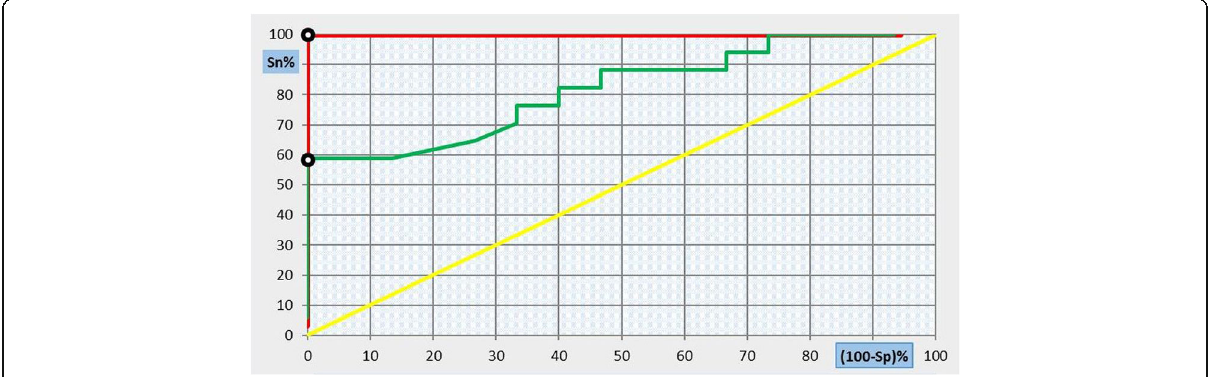
Fig. 4 ROC curve analysis showing the diagnostic performance of ADC for discriminating red from infiltrated